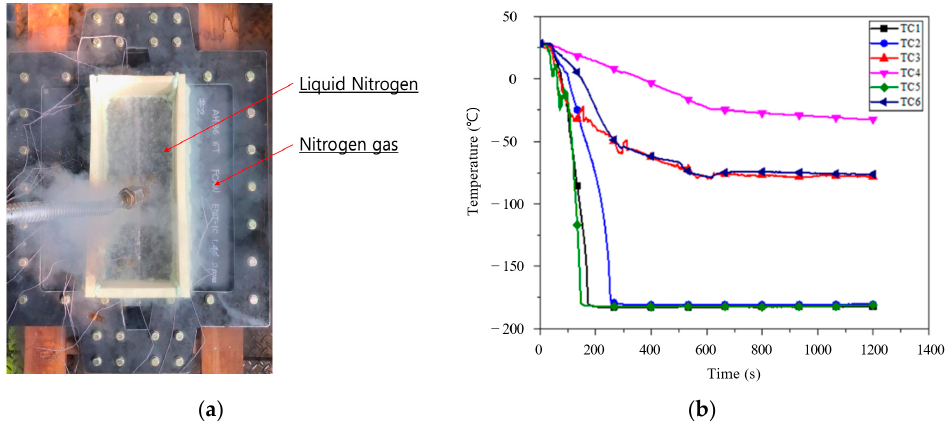
Figure 11. ( a ) Image of LN 2 exposure on the welded steel plate and ( b ) the typical cooldown curves of test points during the LN 2 experiment.